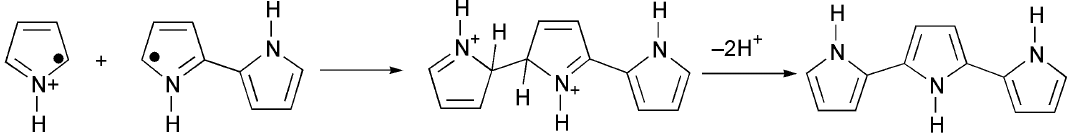
Figure 4. The schematic illustration of Py trimers’s synthesis. Reproduced from [88] with permission of The Royal Society of Chemistry.